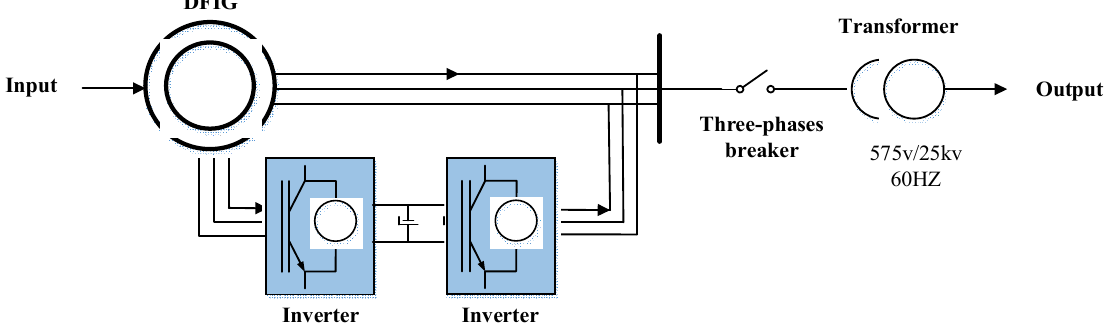
Figure 4. Working mechanism of the DFIG in the wind farm.